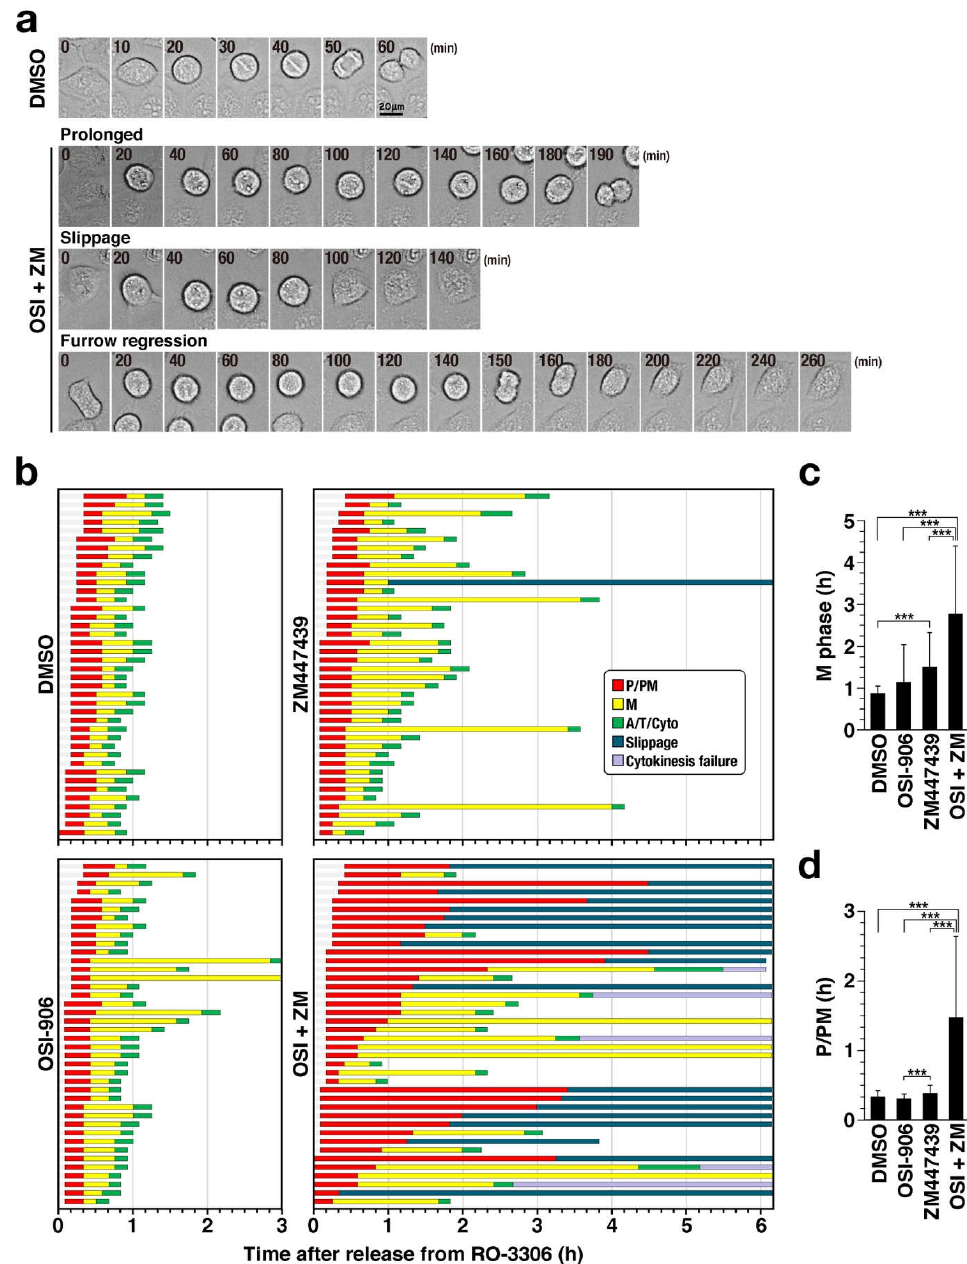
Figure 4. Combination of OSI-906 and ZM447439 causes mitotic slippage and cytokinesis failure. HeLa S3 cells were treated with 6 µM RO-3306 for 20 h and with either 3 µM OSI-906, 1 µM ZM447439, or their combination (OSI + ZM) for 1 h at end of the RO-3306 treatment. The cells were released by washing out the drug and then cultured continuously with inhibitors without RO-3306. Immediately after the release from RO-3306 treatment, time-lapse imaging was started. Images of bright field and Hoechst 33342 fluorescence (DNA) were captured every 5 min. ( a ) Representative images of cells with prolonged M phase, mitotic slippage, and furrow regression are shown. ( b ) The mitotic cells were classified based on their morphologies of cell shape and chromosomes into three groups: prophase/prometaphase (P/PM), metaphase (M), and anaphase/telophase/cytokinesis (A/T/Cyto). Based on the time-lapse images, the duration of each mitotic sub-phase (P/PM, M. A/T/Cyto) in individual cells are plotted in the graph (n = 40). Cells that exited mitosis without chromosome segregation and cytokinesis are shown as “Slippage.” Cells whose cleavage furrows ingressed and then regressed were shown as “cytokinesis failure.” ( c , d ) Mean values of the durations of M phase ( c ) and P/PM ( d ) were plotted as mean ± SD. p -values were calculated using the Games–Howell multiple comparison test. *** p <